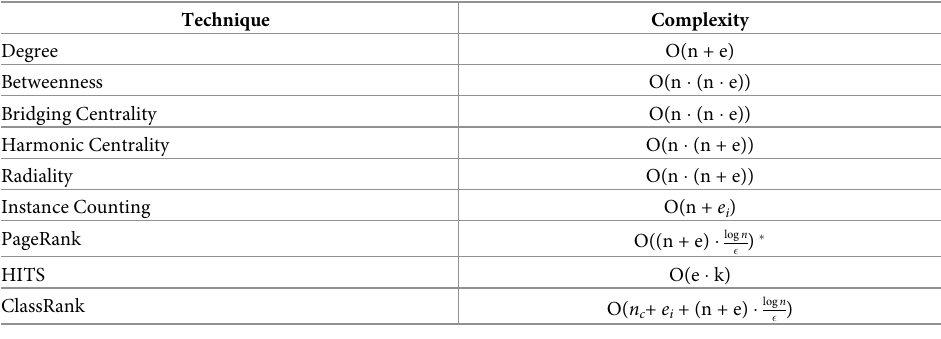
Table 6. Computational cost of the techniques